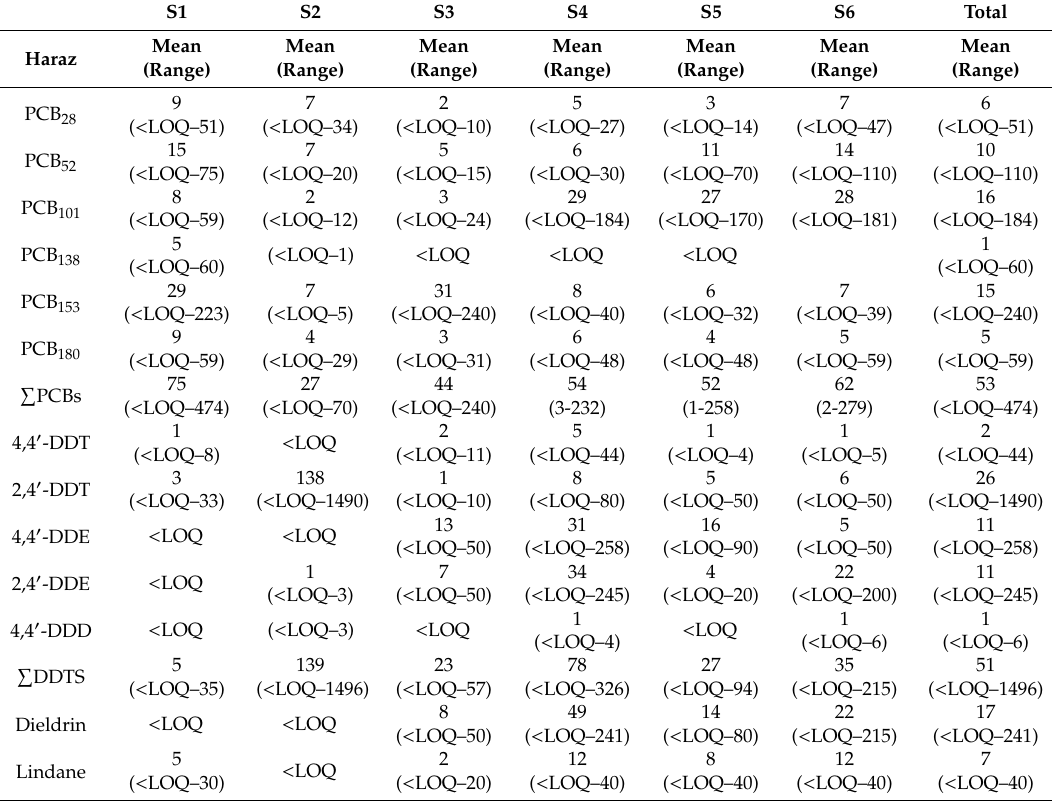
Table 3. Concentrations (mean and range) in ng / L of POPs in water samples of Haraz River collected from Iran. LOQ, limit of